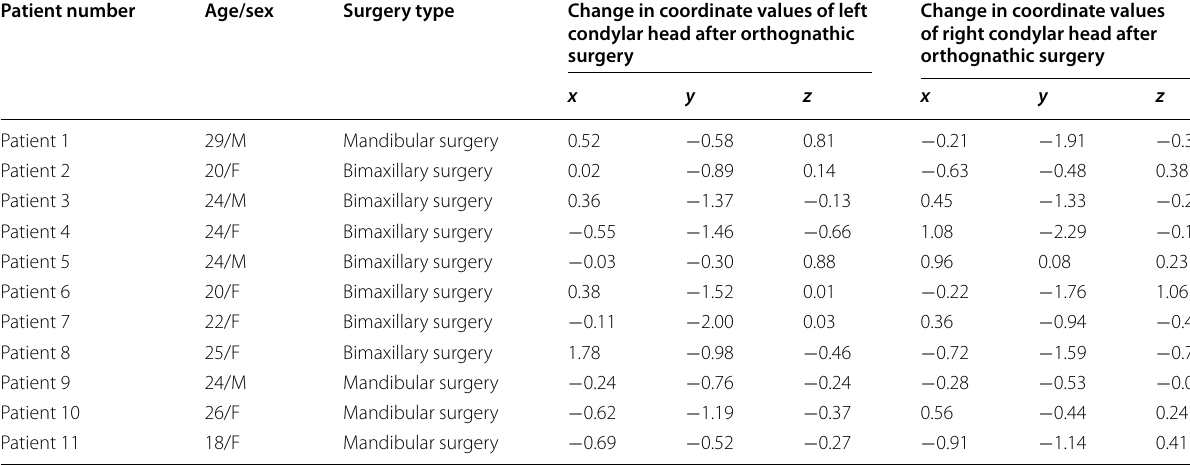
’–‘value on the x-axis indicates right; ‘ on the z-axis indicates advance; ‘